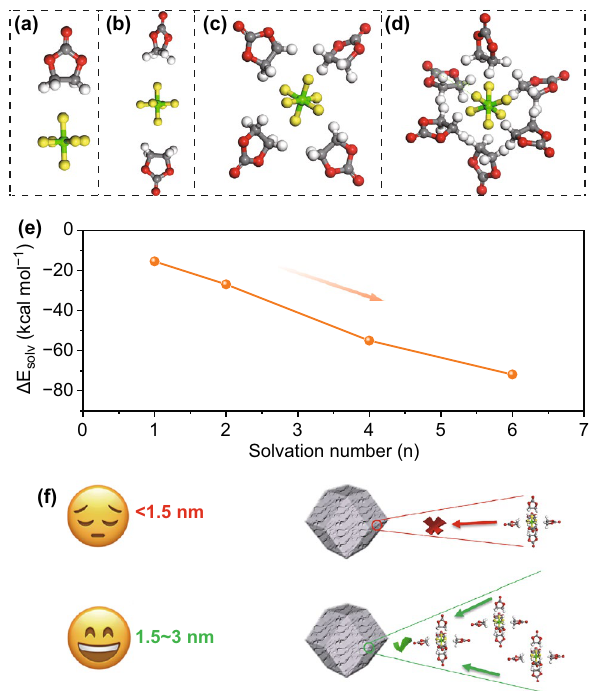
Fig. 6 Optimized solvation structures of PF 6− (EC) i ( i = 1, 2, 4, 6) by DFT calculations: a PF 6− (EC) 1 , b PF 6− (EC) 2 , c PF 6− (EC) 4 and d PF 6− (EC) 6 . e Variation tendency of solvation energies of PF 6− (EC) i as a function of the solvation number. f Schematic illustration of elec‑ trosorption of solvated PF 6− ions with a finite pore